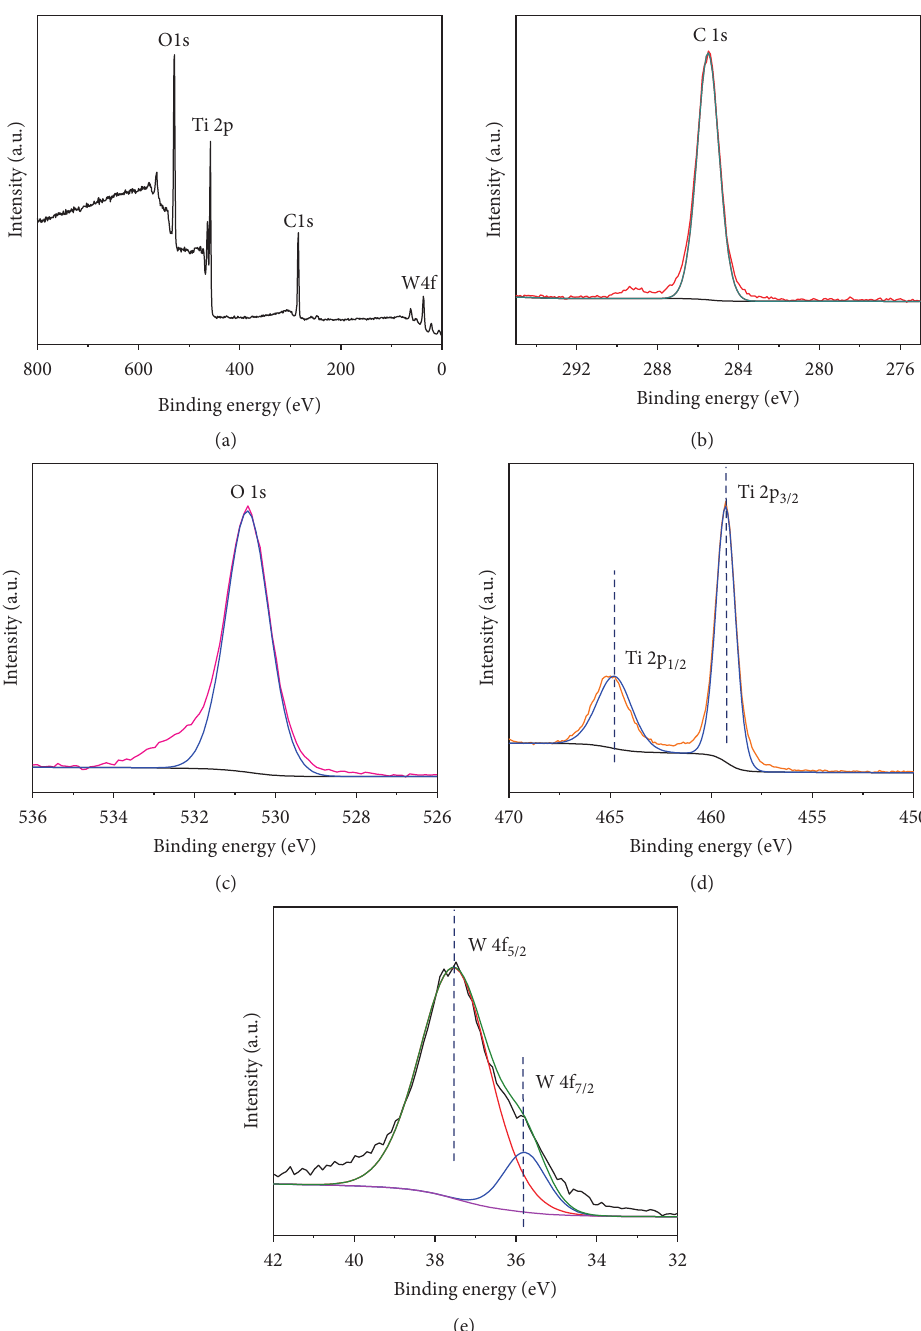
Figure 7: XPS spectra of 5% WO 3 /TiO 2 nanofibers. (a) Survey spectra, (b) C 1s, (c) O 1s, (d) Ti 2p, and (e) W